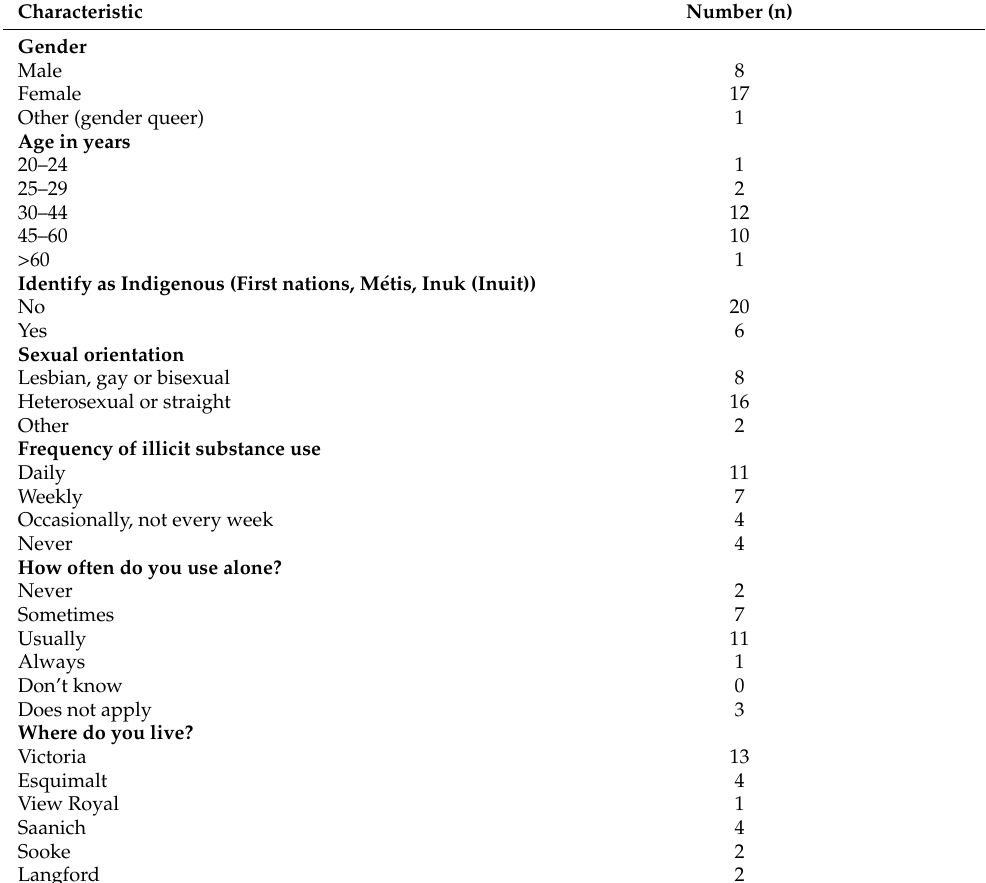
Table 2. Characteristics of the sample (N =